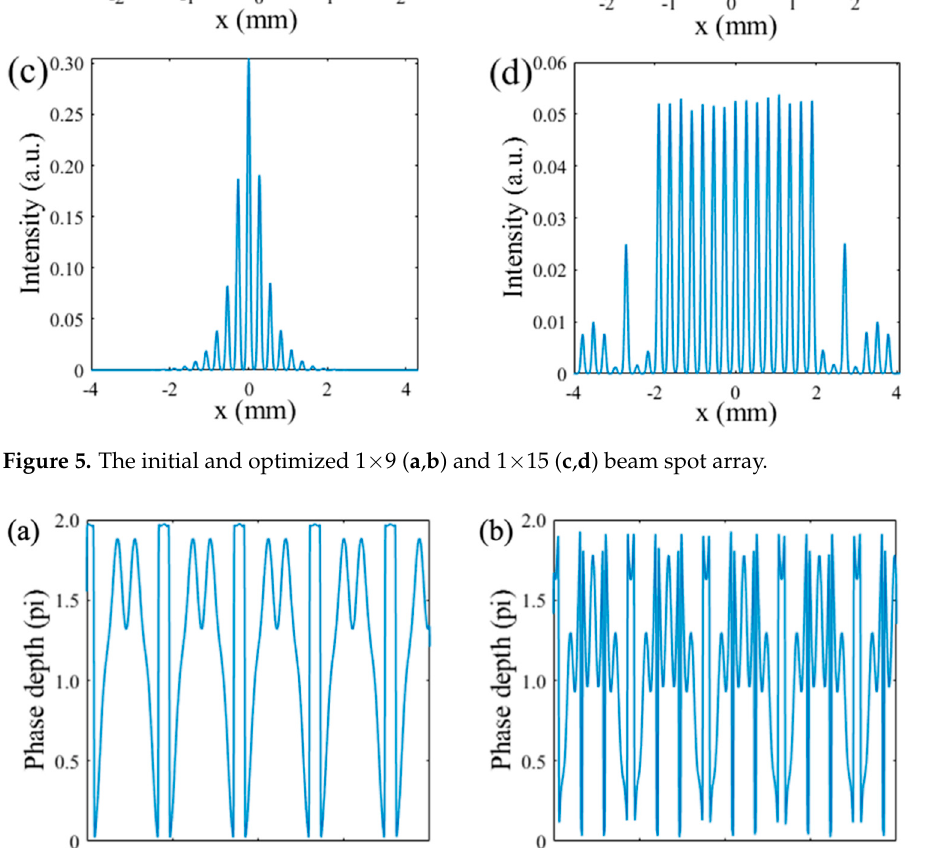
Figure 7. Progression of the optimization for ( a ) 1 × 9 and ( b ) 1 × 15 spot array in the simulation. 4. Experiments The optical system shown in Figure 8 was constructed to further validate the pro- posed method for the spot array generation. A collimated laser beam with a Gaussian waist of 60 um was placed at the front focal plane of the Fourier lens (L1) with a focal length of 127 mm. The central wavelength of the laser was set at 1550 nm in this work. The LCOS device was placed at the back focal plane of L1. The LCOS device had a reso- lution of 1920 × 1200 and a pixel size of 8 um [29]. This LCOS device was also designed for 1550 nm operation. The reconstructed light field was directed to the infrared camera by a pellicle beam splitter. During the optimization process, the PC controlled both the LCOS device and the camera. The spot profile captured by the camera was used as the feedback to iteratively update the phase patterns displayed on the LCOS device. In this way, the optimization algorithm also took the defects within the LCOS device into ac- count, particularly the fringing field effect. In the experiment, the initial holograms were generated through the simulation pro- cess, which was described in the above. Therefore, the spot array generated by the initial hologram can be closer to the target profile, potentially leading to a faster optimization process. Nevertheless, there still would be some discrepancy between the simulation and experiment since the simulation cannot cover every aspect of the actual optical system, including the misalignment of the optical system, manufacturing errors within the lens, depolarization effect and the phase flicker within the LCOS device, etc. It should be noted that the impact of the depolarization effect of the LCOS device was particularly strong, especially when a large spot array was required. In this case, the intensity of the central spot within the array would be higher than expected. As a result, the target intensity of